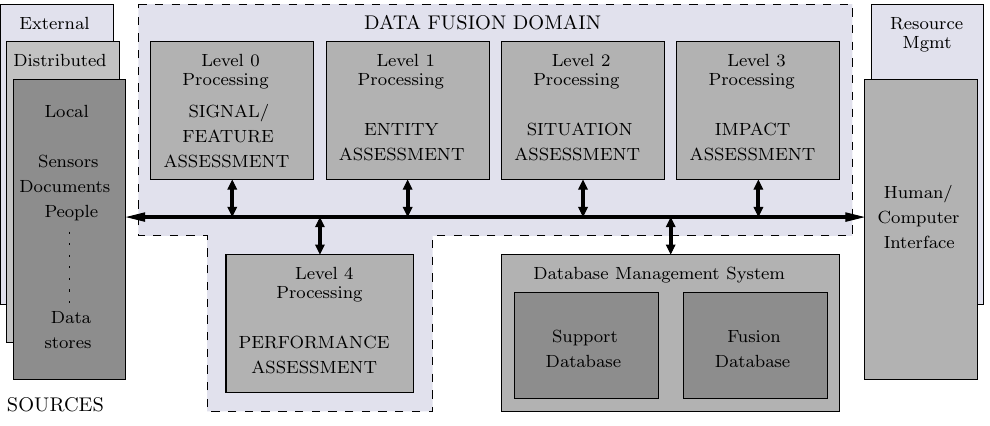
Figure 3: The revised JDL DF Model (2004)